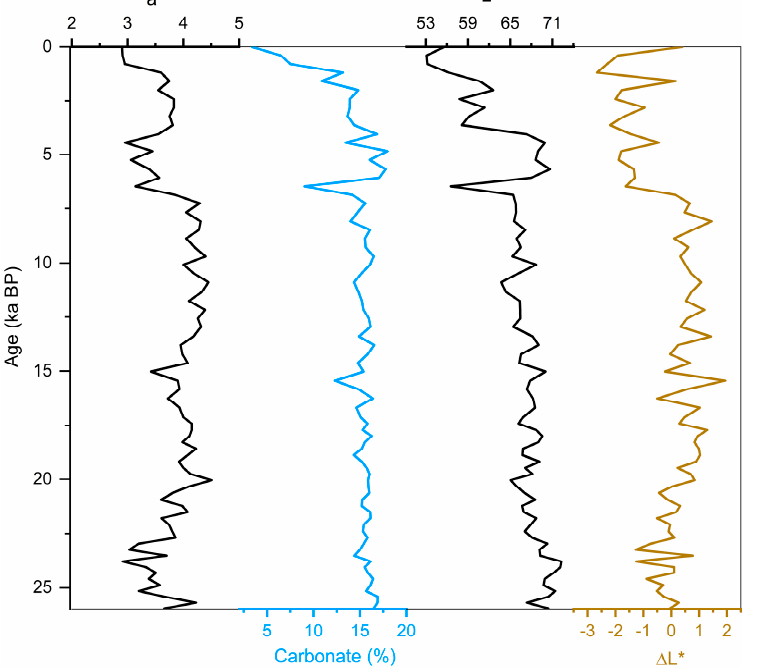
Figure 6. Variations in calibration lightness ( ∆ L*), lightness (L*), carbonate content (%), redness (a*) versus depth of the ZSP section. (L*, carbonate content and a* are from reference [102].)